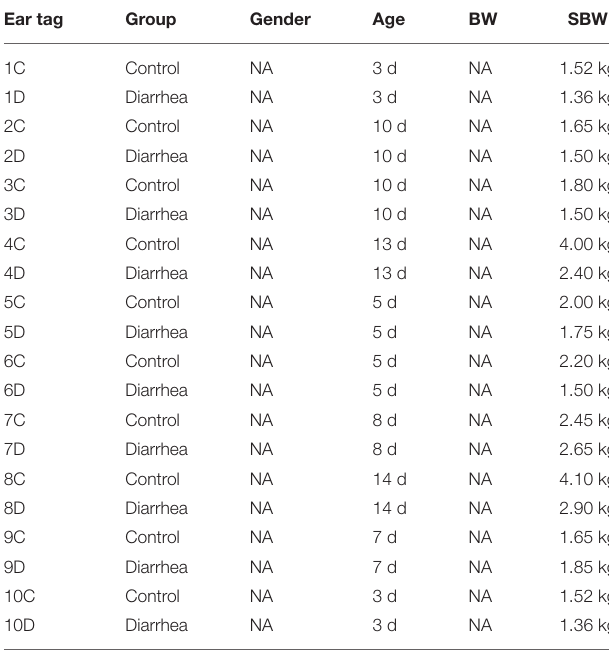
TABLE 1 | The basic information of experimental goat